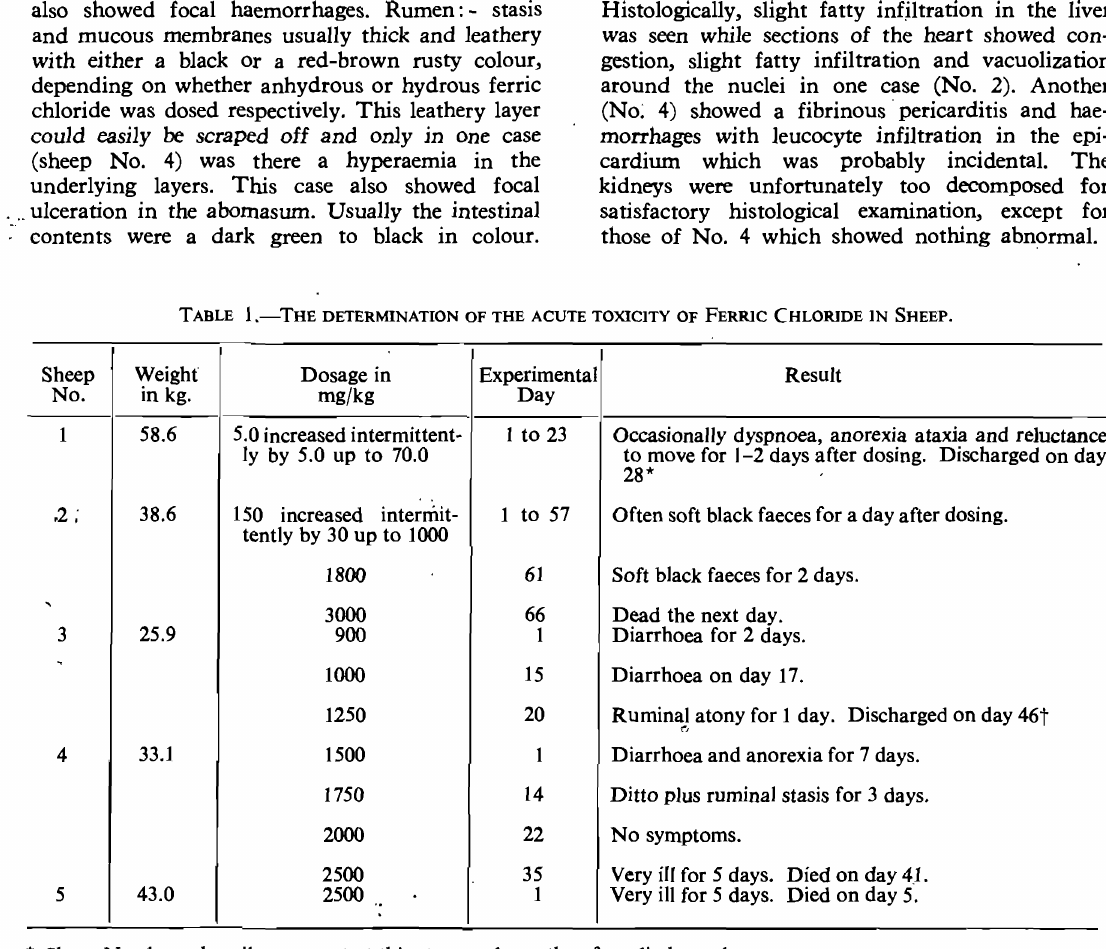
TABLE 2.-THE CHRONIC TOXICITY OF FECI. IN SHEEP AND A GOAT.